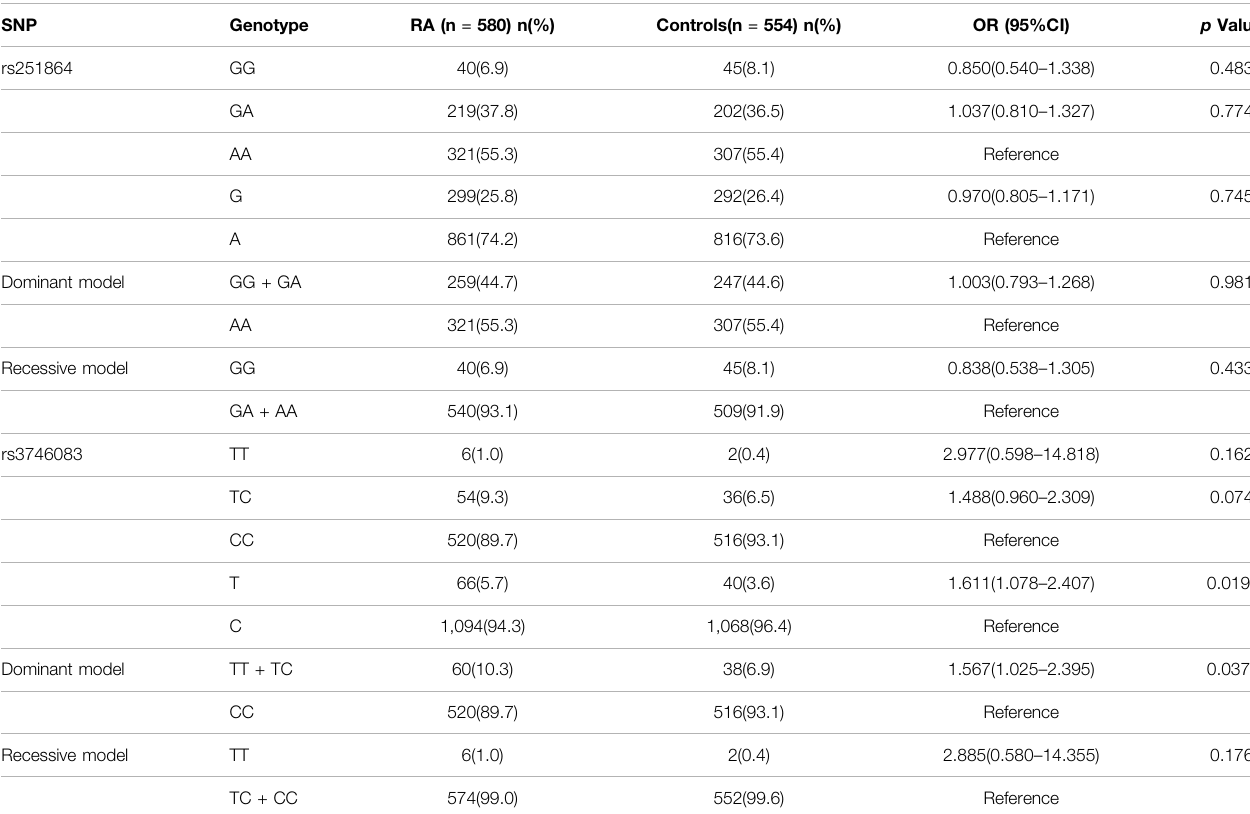
TABLE 2 | Allele and genotype frequencies of the TTP gene SNPs in RA patients and healthy